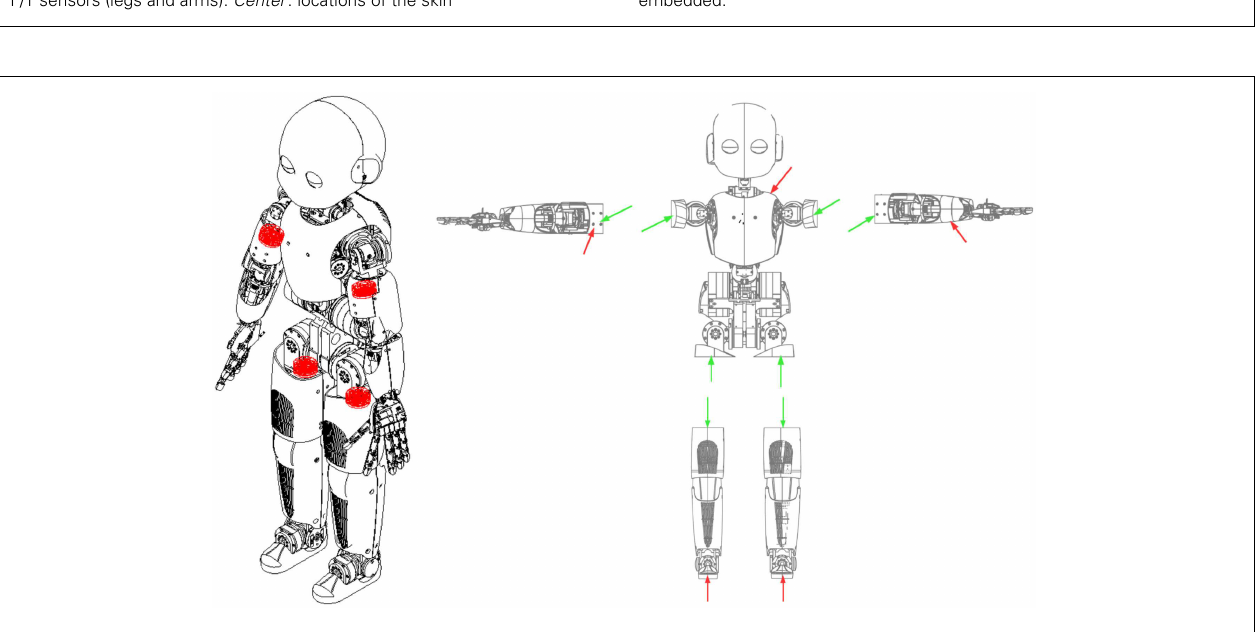
FIGURE 2 | Mechanical schemes of the humanoid robot iCub with force/torque sensors, gyroscopes, and accelerometers highlighted in green . Left : locations of the six proximal six-axis F/T sensors (legs and arms). Center : locations of the skin